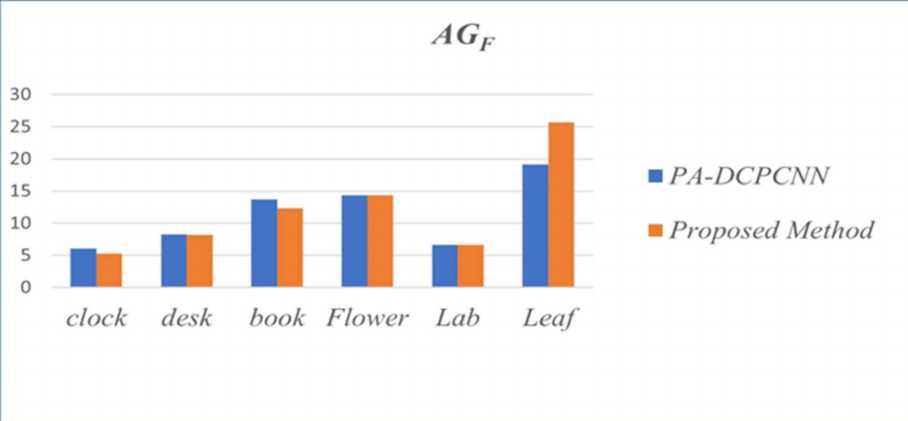
Figure 28. Performance evaluation of image-fusion techniques in reference to AG F .